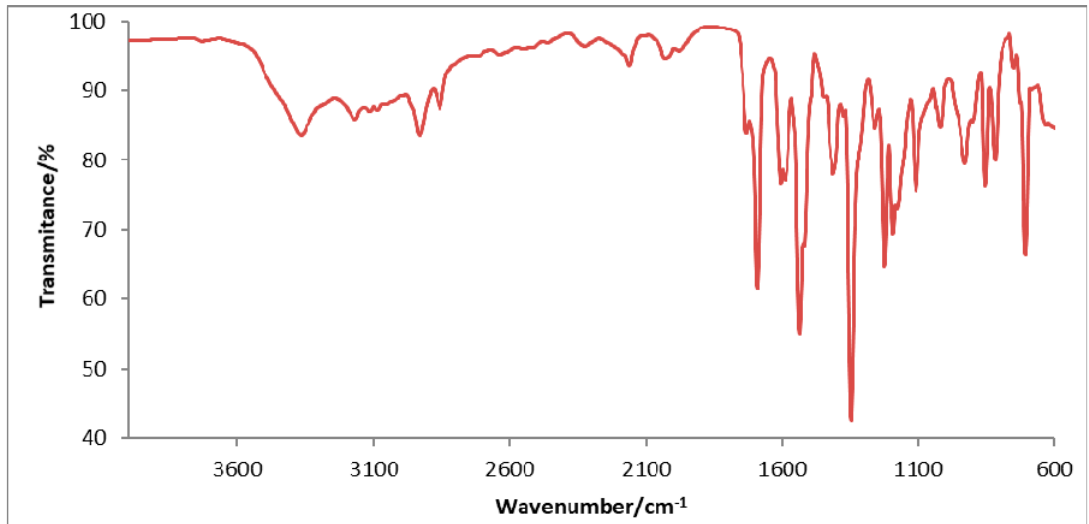
Figure 1. FTIR spectrum of organic ligand.